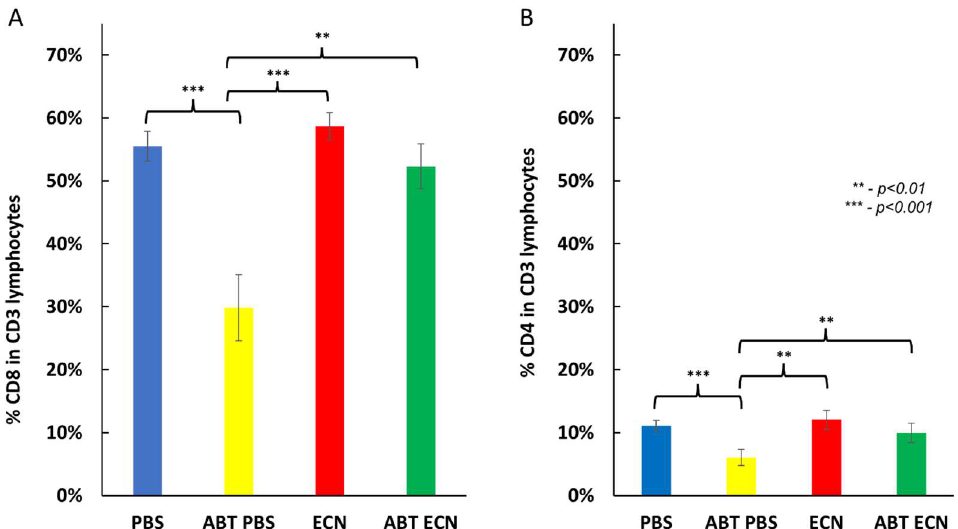
Figure 7. Identification of subsets of T lymphocytes. Different tumor tissue sections stained with CD3, CD4 and CD8 antibodies and were analyzed by CODEX multiplexed imaging. ( A ) Percent [%] of CD8+ cells in CD3+ cell population. ( B ) Percent [%] of CD4+cells in CD3+ cell population. PBS— PBS-injected group; ABT PBS —antibiotic-pretreated and PBS-injected group; EcN —EcN/pMUT-gfp Kn r injected group; ABT EcN —antibiotic-pretreated and EcN/pMUT-gfp Kn r injected group. Data are representative of three independent experiments ( n = three mice per group). The statistical significance was calculated by the Student’s t-test where ** indicates p < 0 .01 and *** p < 0 .001.